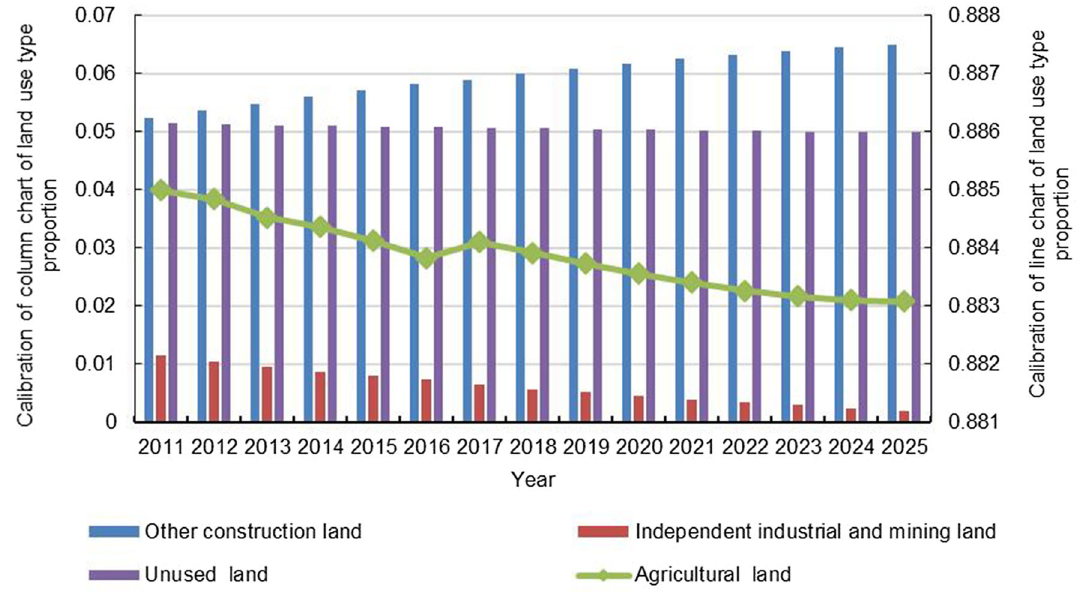
Fig. 4 Trend chart of proportion of land use types in Mentougou District from 2011 to 2025